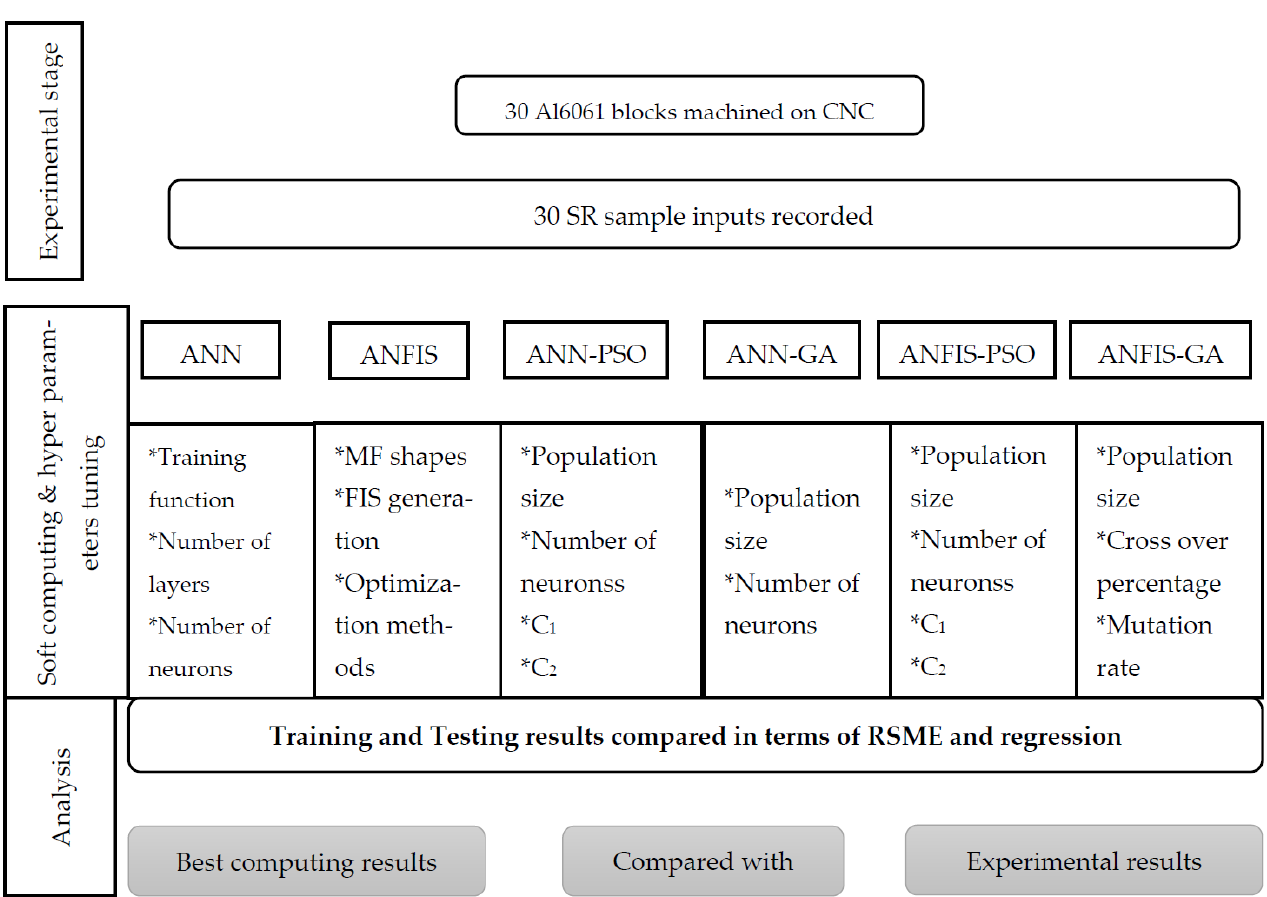
Figure 5. Flowchart of the study procedure.